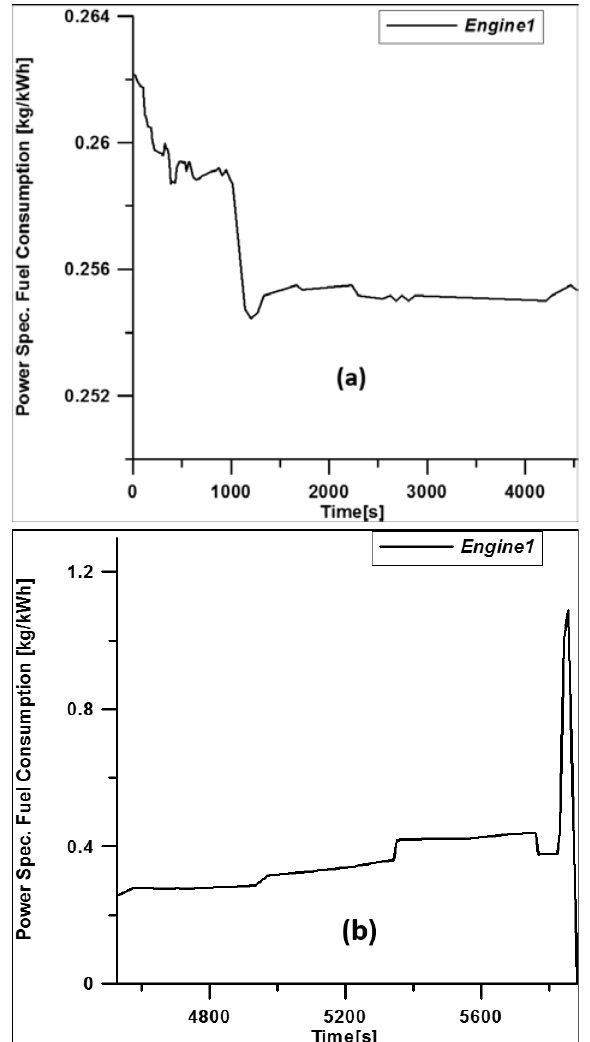
Figure 12. Fuel consumption during the flight mission. In ( a ), the take-off, climb, and initial cruise phases; in ( b ), the last cruise and landing phases.